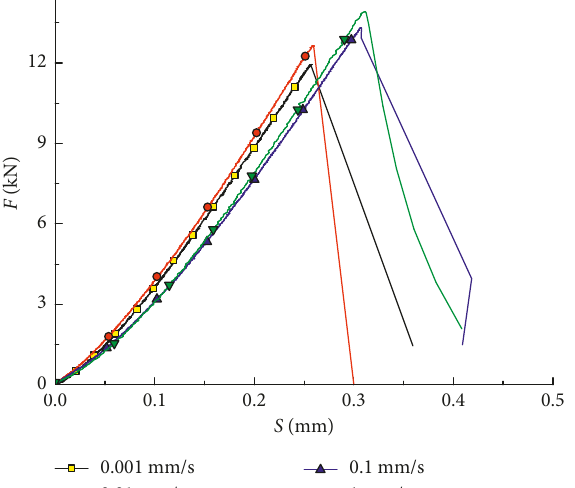
Figure 8: Load-displacement curves of specimens under strip loading.